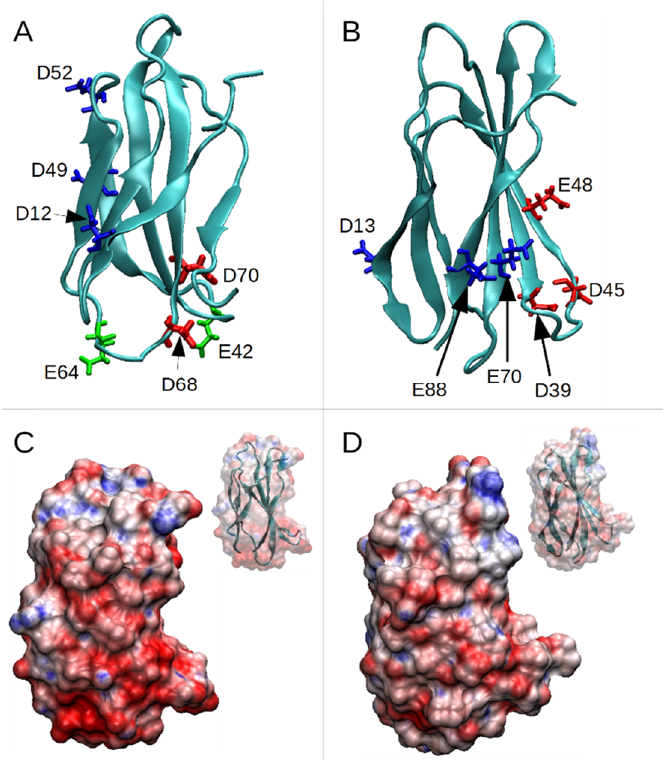
Figure 1. High-affinity residues and electrostatic potential of PL1 binding partners. ( A ) structure of FN-EDB showing three areas of charged residues, (1) D52, D49, and D12; (2) D68 and D70; and (3) E42, D68, and E64. ( B ) structure of TNC-C showing three areas of charged residues, (1) D13, E70 and E88; (2) D39 and D45; (3) E48. ( C ) electrostatic potential surface of FN-EDB (red represents regions with a negative potential, while blue represents positive ones); the inset shows the cartoon representation of the protein. ( D ) electrostatic potential surface of TNC-C.